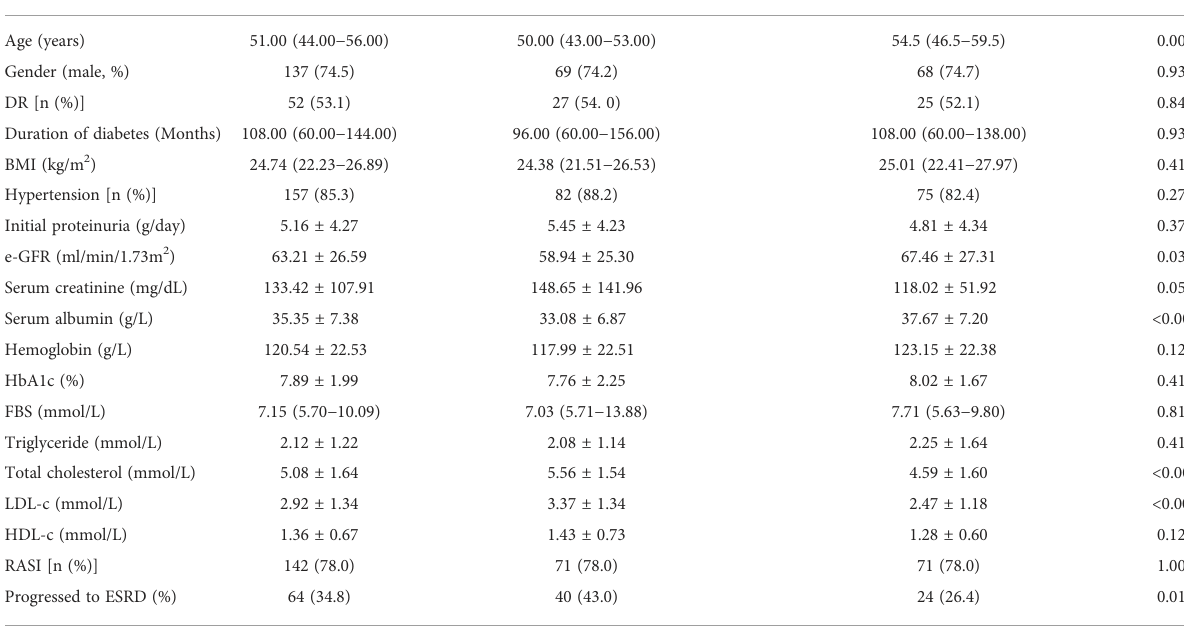
TABLE 1 Baseline clinical features of 184 DKD